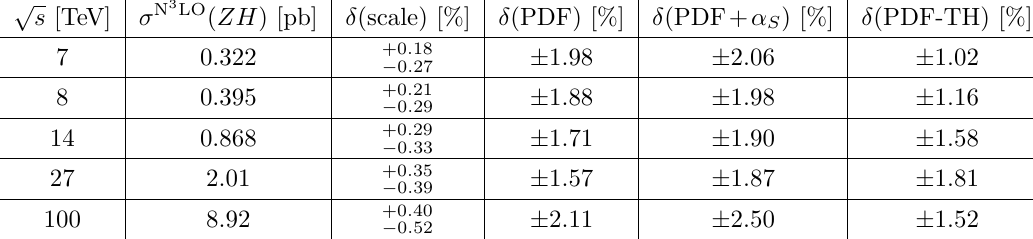
Table 12 . The same as in table 9, but for µ 0 = M H + M Z